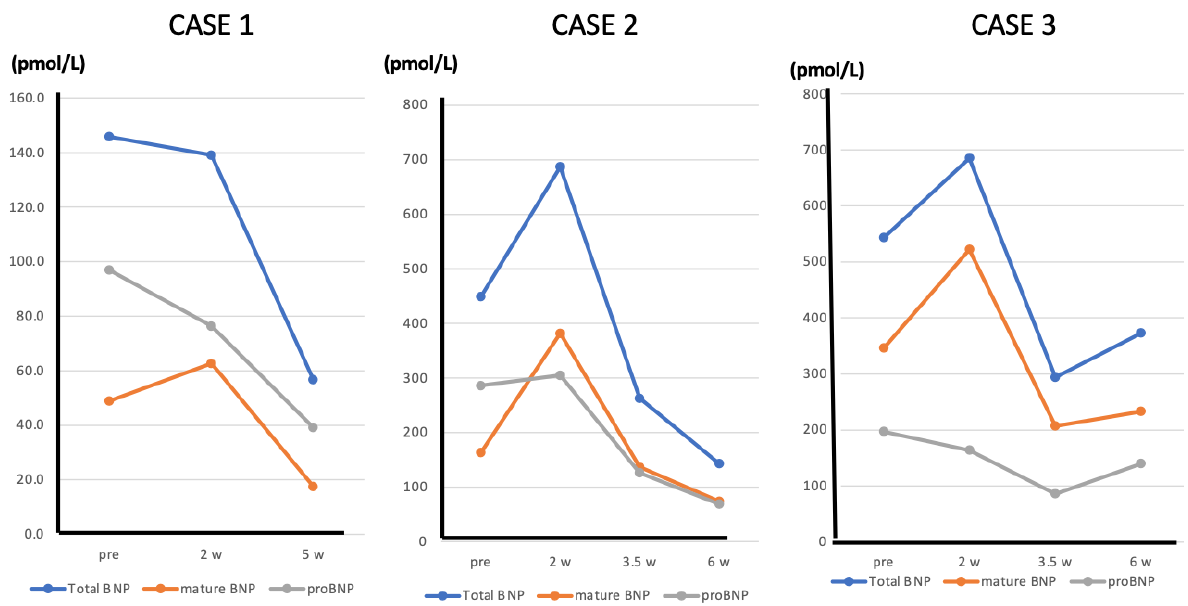
Figure 6. Line graphs showing the changes in total BNP, mature BNP, and proBNP in Cases 1, 2, and 3 before and after initiating ARNI administration.